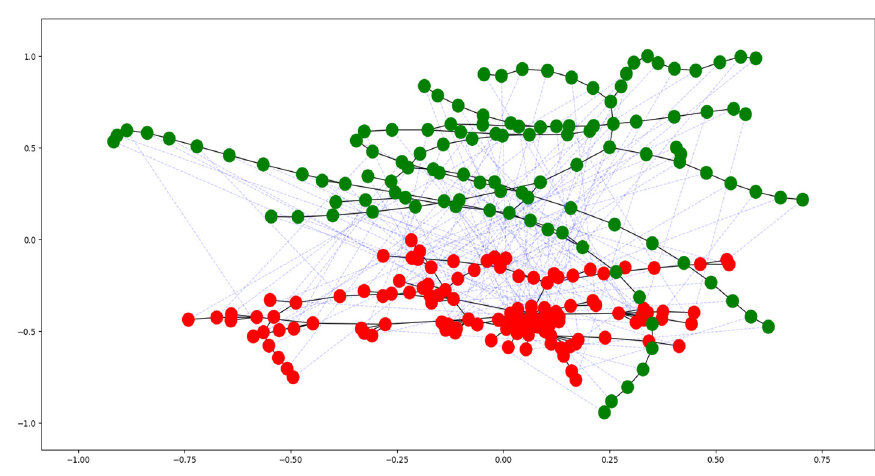
Figure 8. N = 118 topology of the power grid.